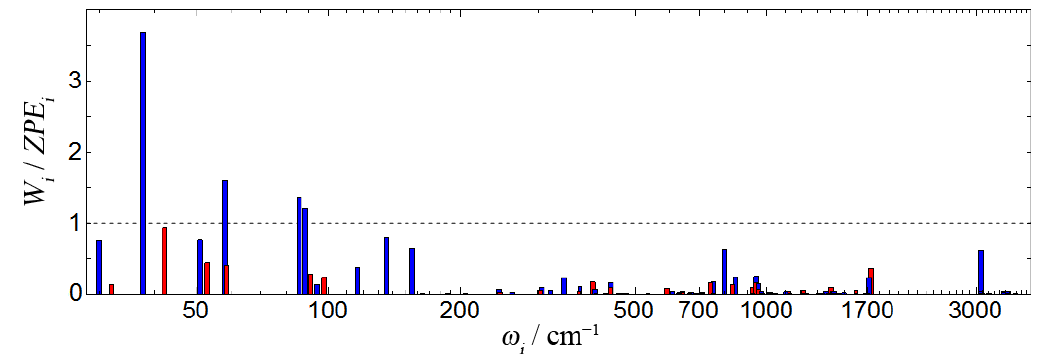
Figure 8. Classical accessibility to the MECI a geometry for NAPA B (red) and NAPMA B (blue). For each normal mode, the ratio between the normal mode’s potential energy W i = ω 2 zero point energy, ZPE i = ω i /2, is shown. A ratio W i ( Q i ) / ZPE i < 1 for all normal modes indicates a classically-accessible CI.